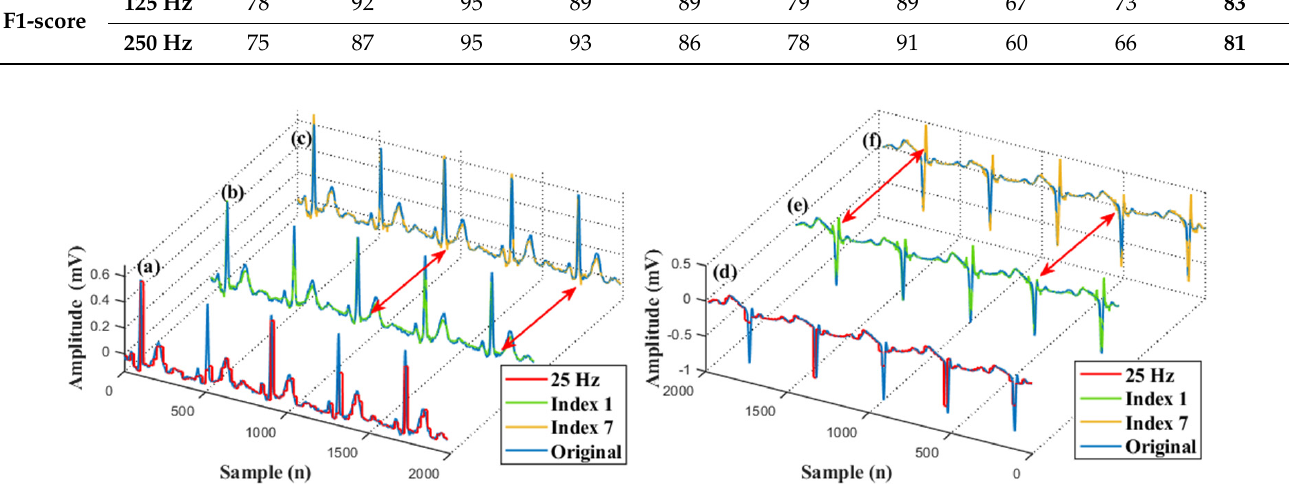
Figure 9. An example of reconstructed signals. ( a ) A superimposed waveform of the original and compressed signal (Lead II). ( b ) A superimposed waveform of the original and reconstructed signal (Lead II). ( c ) A superimposed waveform of the original and reconstructed signal (Lead II). ( d ) A superimposed waveform of the original and compressed signal (Lead V2). ( e ) A superimposed waveform of the original and reconstructed signal (Lead V2). ( f ) A superimposed waveform of the original and reconstructed signal (Lead V2).